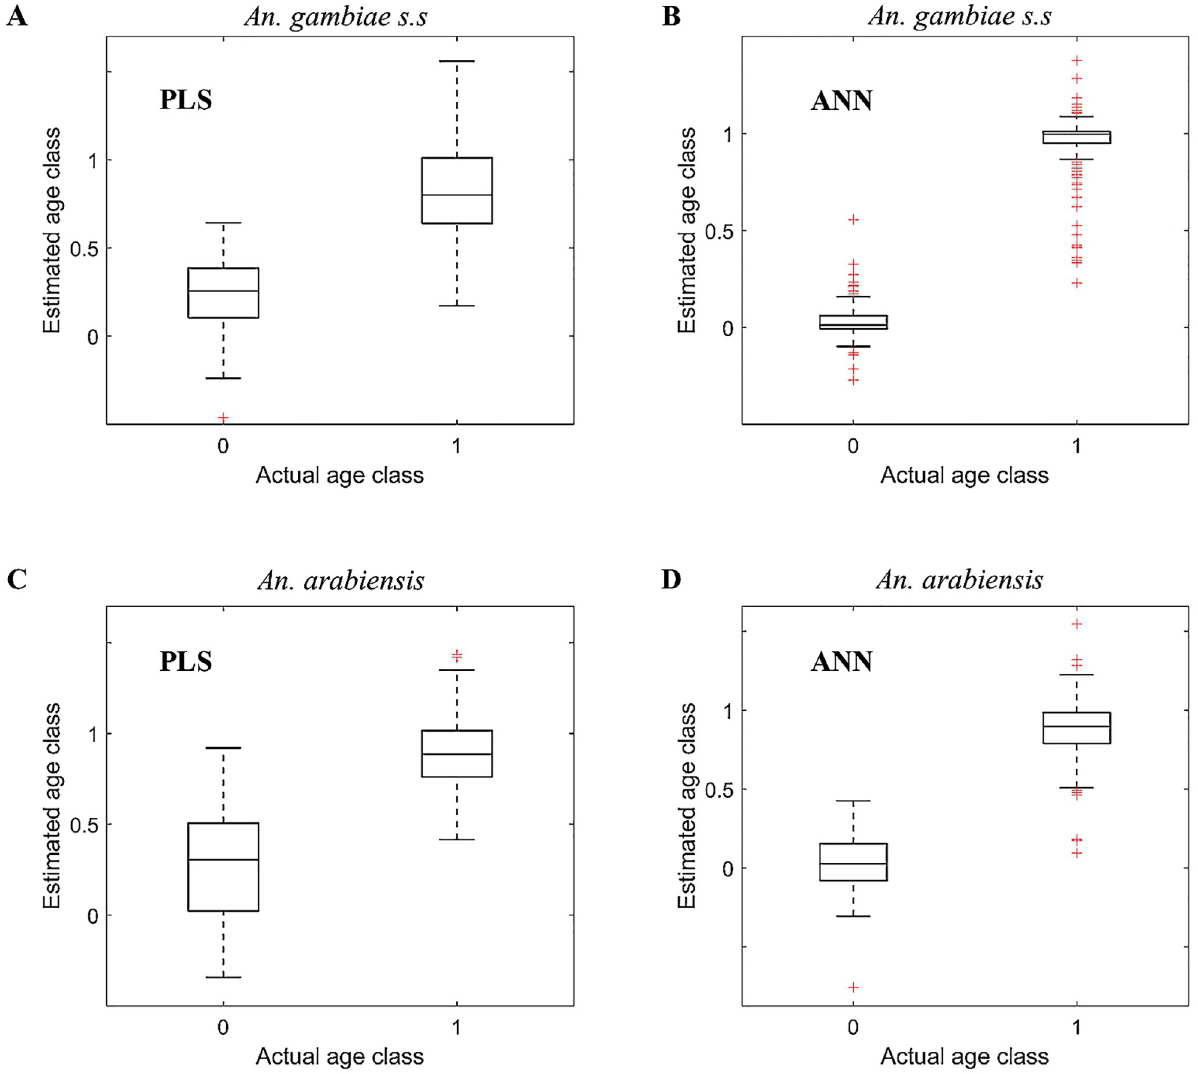
Fig 3. Box plot of directly trained PLS (A and C) and ANN (B and D) binary classifiers for estimating age classes of An . gambiae (A and B) and An . arabiensis (C and D) in out of sample testing